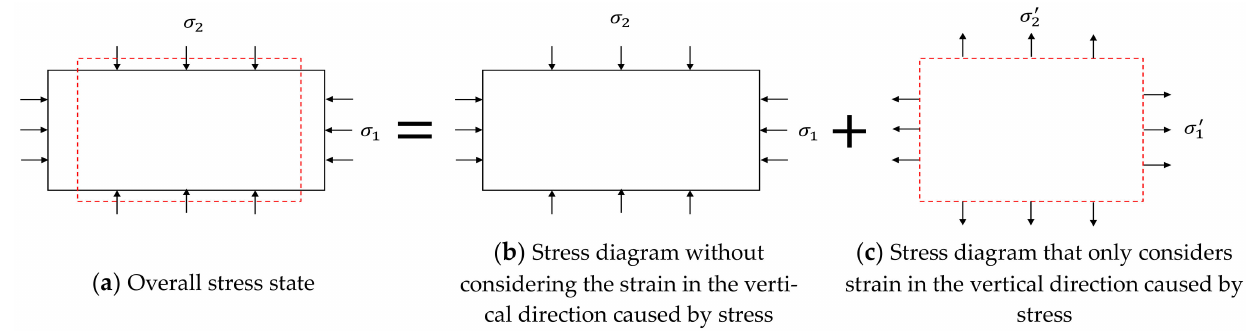
Figure 2. The planar stress decomposition. (The black solid frame in ( a ) indicates the state of the object before the stress, and the red dotted frame indicates the state of the object after the stress; the black solid line box in ( b ) represents the result of not considering the deformation of the object in the vertical direction of the stress; and the red dotted frame in ( c ) indicates that the object only considers the result of deformation in the vertical direction due to the